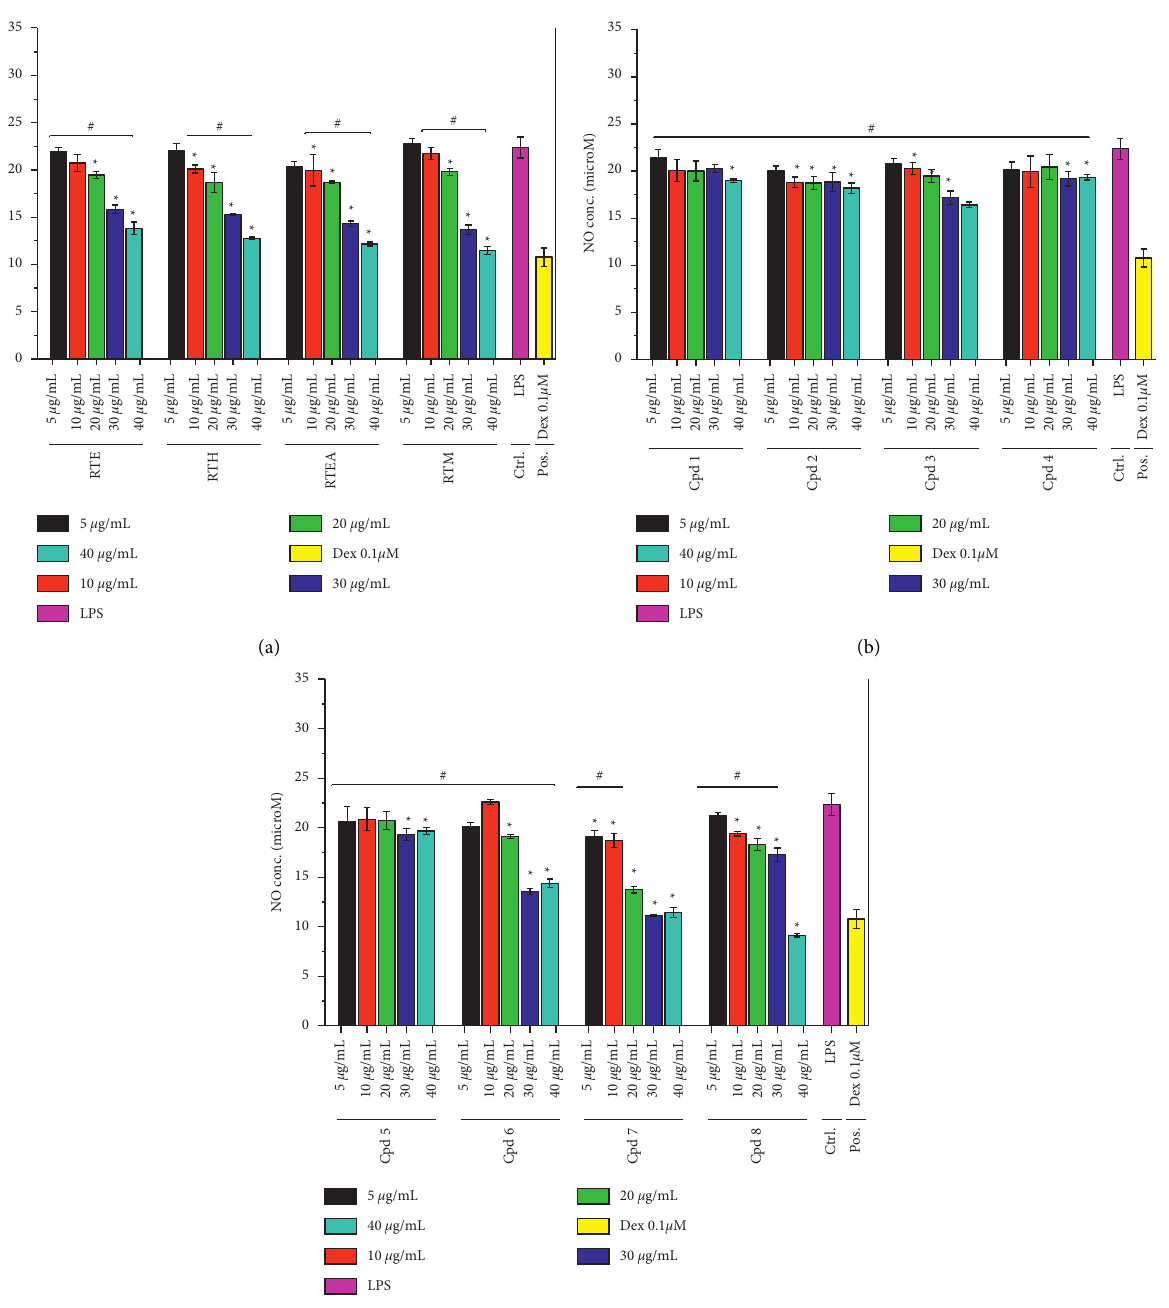
Figure 2: Effects of (a) extract and (b) compounds 1 – 4 and (c) 5 – 8 on the production of NO in LPS-induced RAW264.7 macrophages. Cells were pretreated for 2h with the indicated concentrations (5, 10, 20, 30, and 40 μ g/mL) and then stimulated with LPS (1 μ g/mL) for another 24h. Data are expressed as mean ± S.D. of three independent experiments. ∗ p < 0.05 versus the LPS group; # p < 0.05 versus the positive group. RTH: (n)-hexane fraction; RTEA: ethyl acetate fraction. RTM: methanol fraction; RTE: crude ethanol